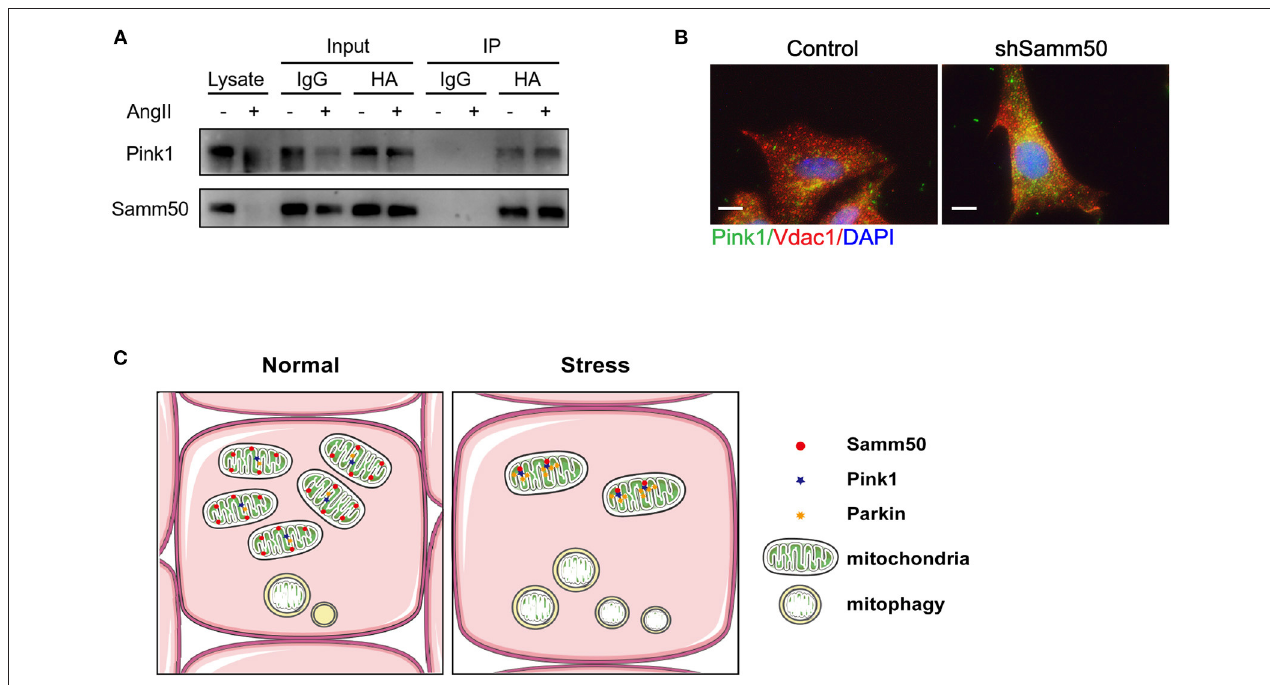
FIGURE 5 | Samm50 interacts with Pink1 to mediate cardiac hypertrophy. (A) Co-immunoprecipitation analysis of Samm50 and Pink1 in HL-1 cells. (B) Representative immunofluorescence images of Pink1 and VDAC1 co-localization in mouse neonatal cardiomyocytes infected with control or shSamm50 lentiviral particles in response to Ang II. Scale bars, 10 µ m. n = 6 for each experiment group. (C) The model of Samm50 regulates cardiac hypertrophy. Under cardiac hypertrophy, Samm50 interacts with Pink1 resulted in Pink1 accumulation, Parkin recruitment, and